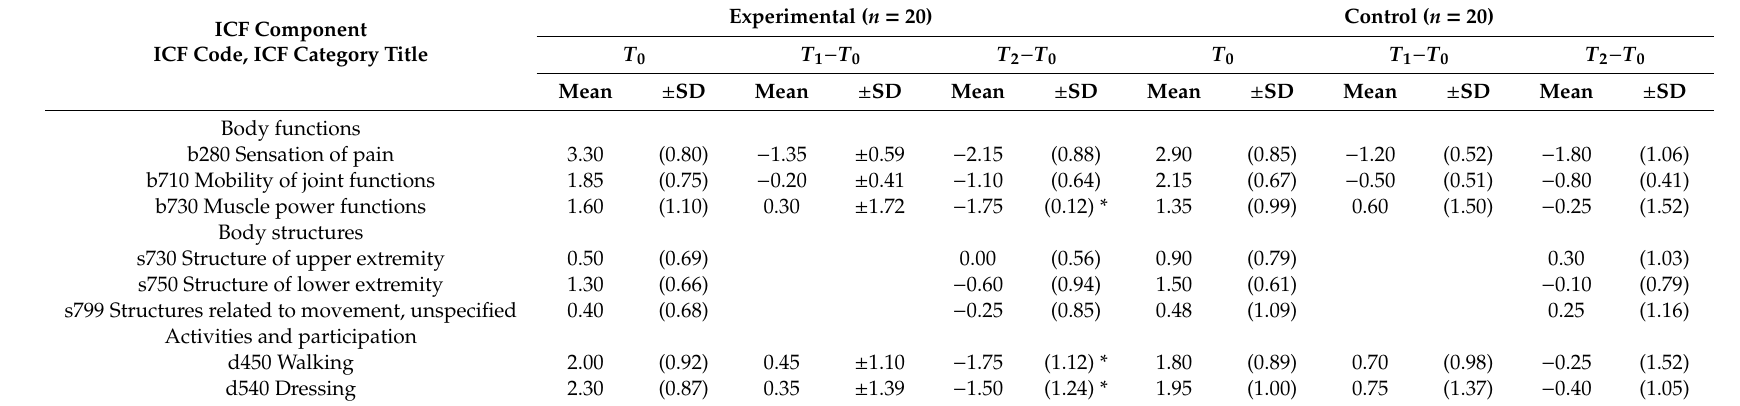
Table 3. Mean changes in ICF-code qualifiers at time point T 1 and T 2 from baseline ( T 0